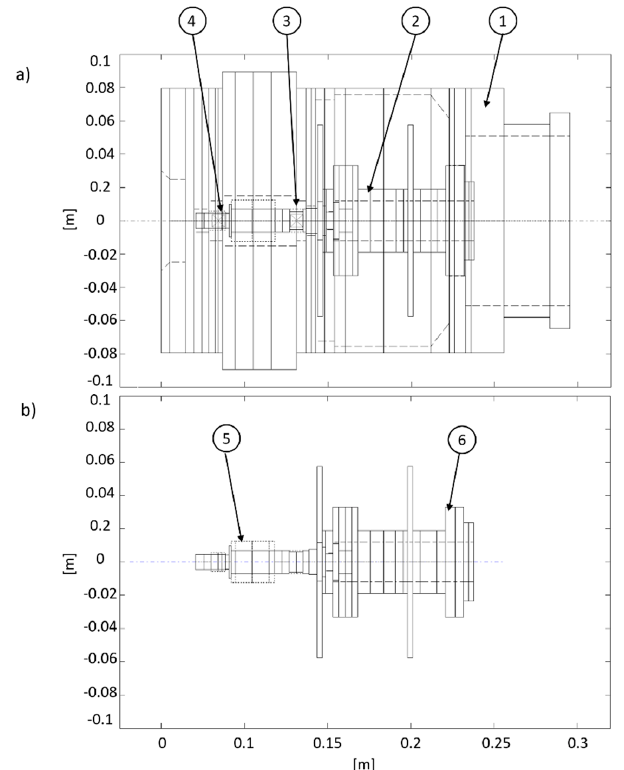
Figure 9. Turbo-molecular pump discretization for Finite Element Method (FEM) rotordynamic analysis. ( a ) Complete system. ( b ) Shaft. (1) Stator. (2) Rotor. (3) Bearing and viscoelastic support on the compressor side (CS). (4) Bearing and viscoelastic support on the shaft end side (SES). (5) Rotating part of the electric motor. (6) Impeller mock-up.